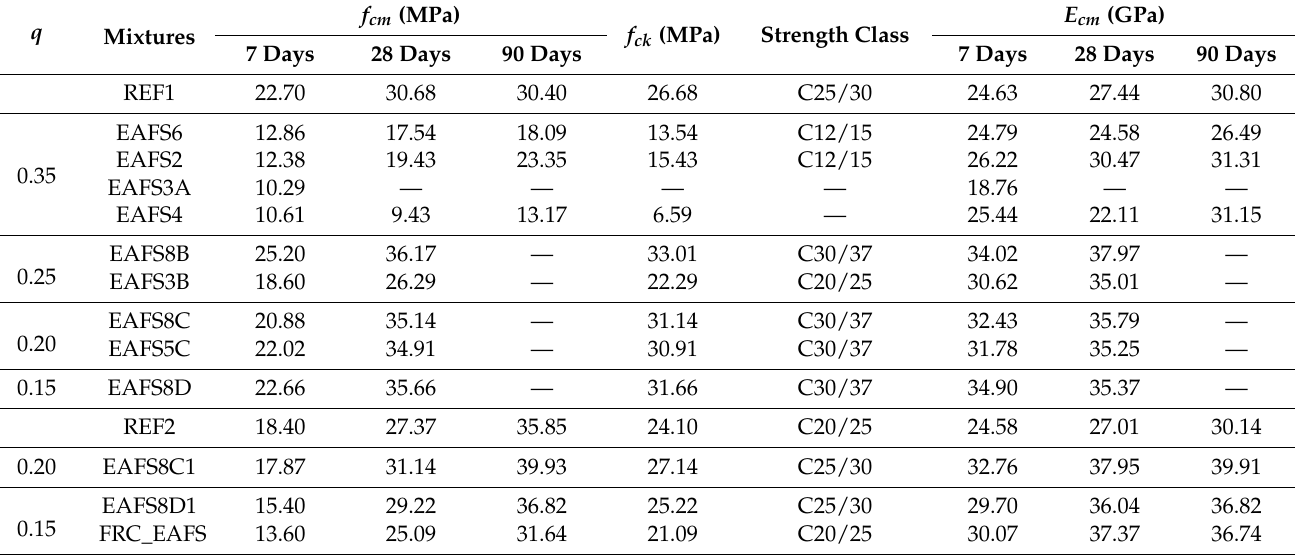
Table 10. Results of the mechanical properties obtained for the REF1, REF2 and EAFS